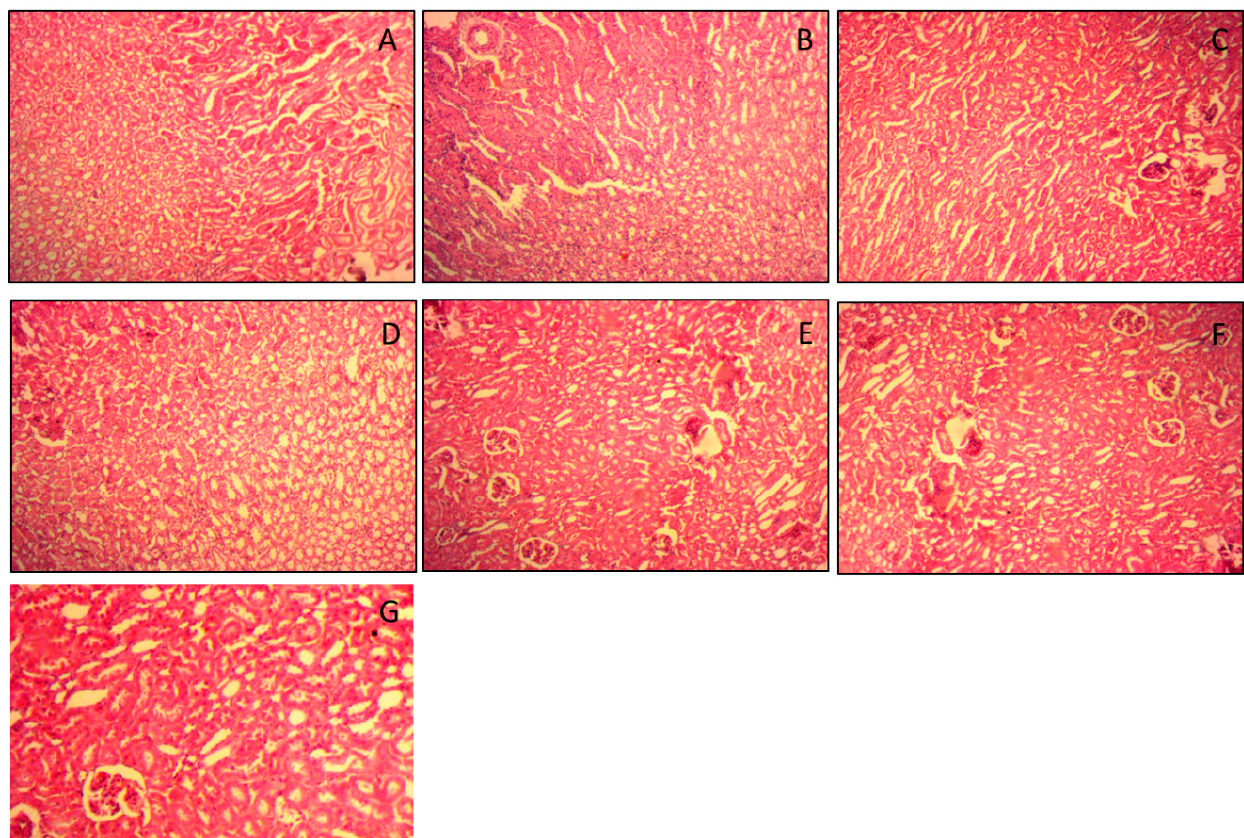
FIGURE 2 - Histopathological analysis. A: Normal control, B: Standard, C: Toxic control, D-F: Prophylactic groups (300-, 600-, & 900 mg/kg respectively), G: Curative group (900